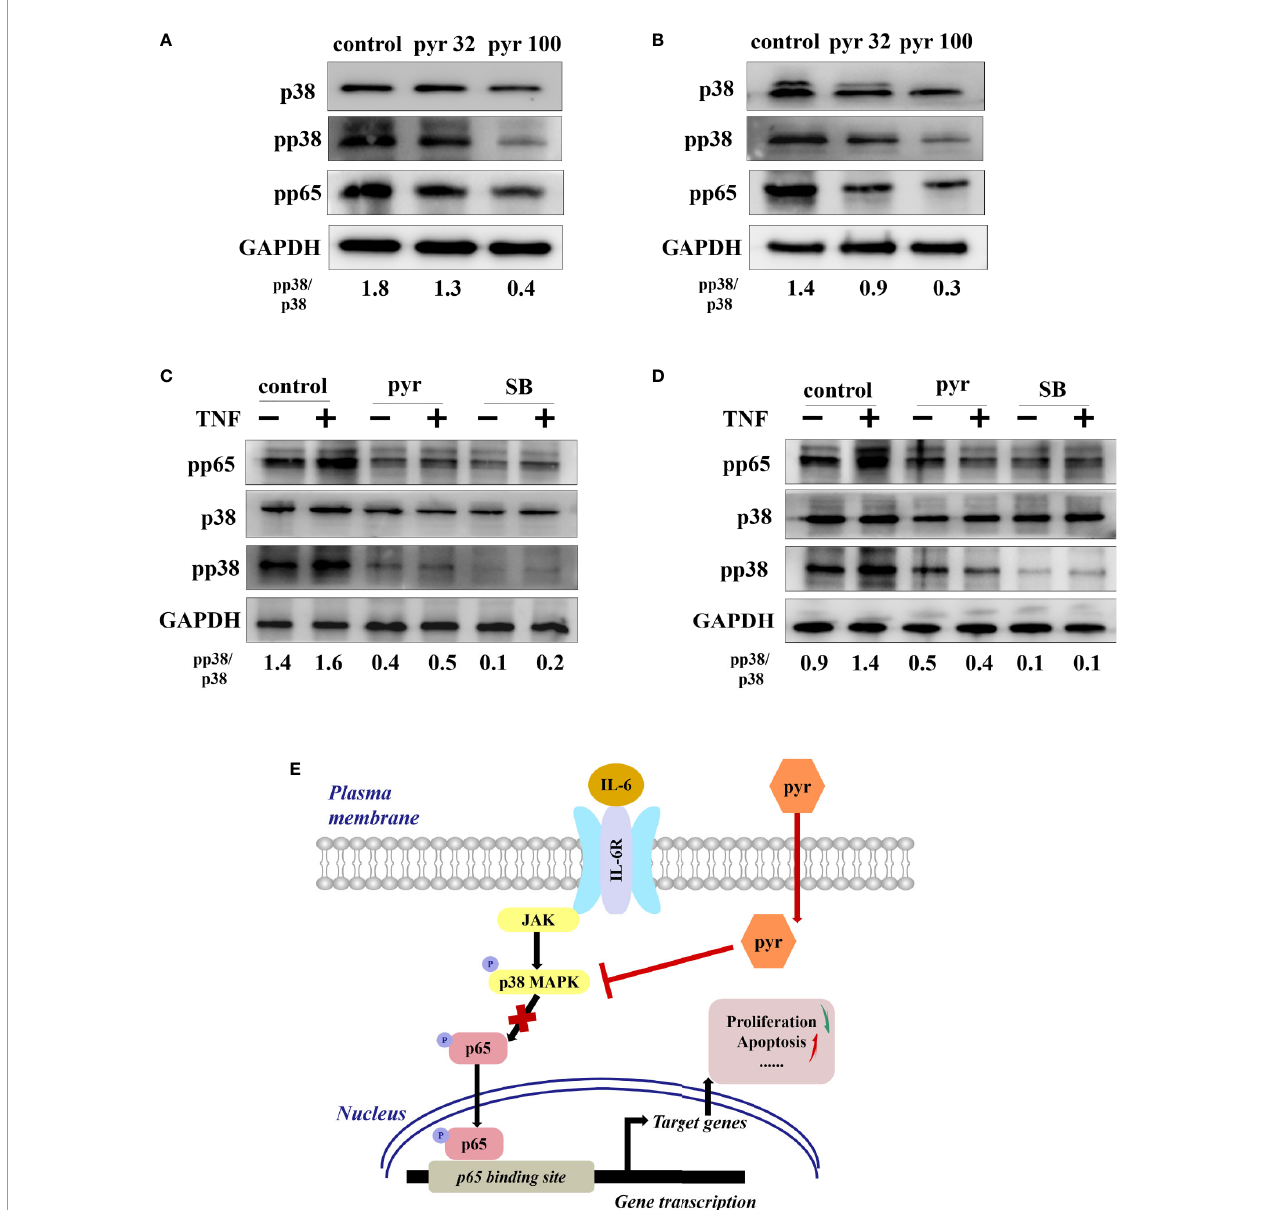
FIGURE 6 | Pyrimethamine regulates the p65/NF- k B pathway in CRPC cells through p38 MAPK inhibition. (A, B) The western blot analysis of the expression of p38, pp38, and pp65 after treatment of 0, 32, and 100 m M pyrimethamine for 24 h in DU145 and PC3 cell lines. The ratio of pp38/p38 was normalized to GAPDH. (C, D) DU145 and PC3 cells were treated for 24 h with pyrimethamine or SB202190 (10 m M) and then treated for 6 h in the absence or presence of TNF-a (10 ng/ ml). Total cell lysates were analyzed by western blot with antibodies against p38, pp38, and pP65. (E) A consolidated model that illustrates a plausible sequence for the mechanism by which pyrimethamine elicits antitumor effects in prostate